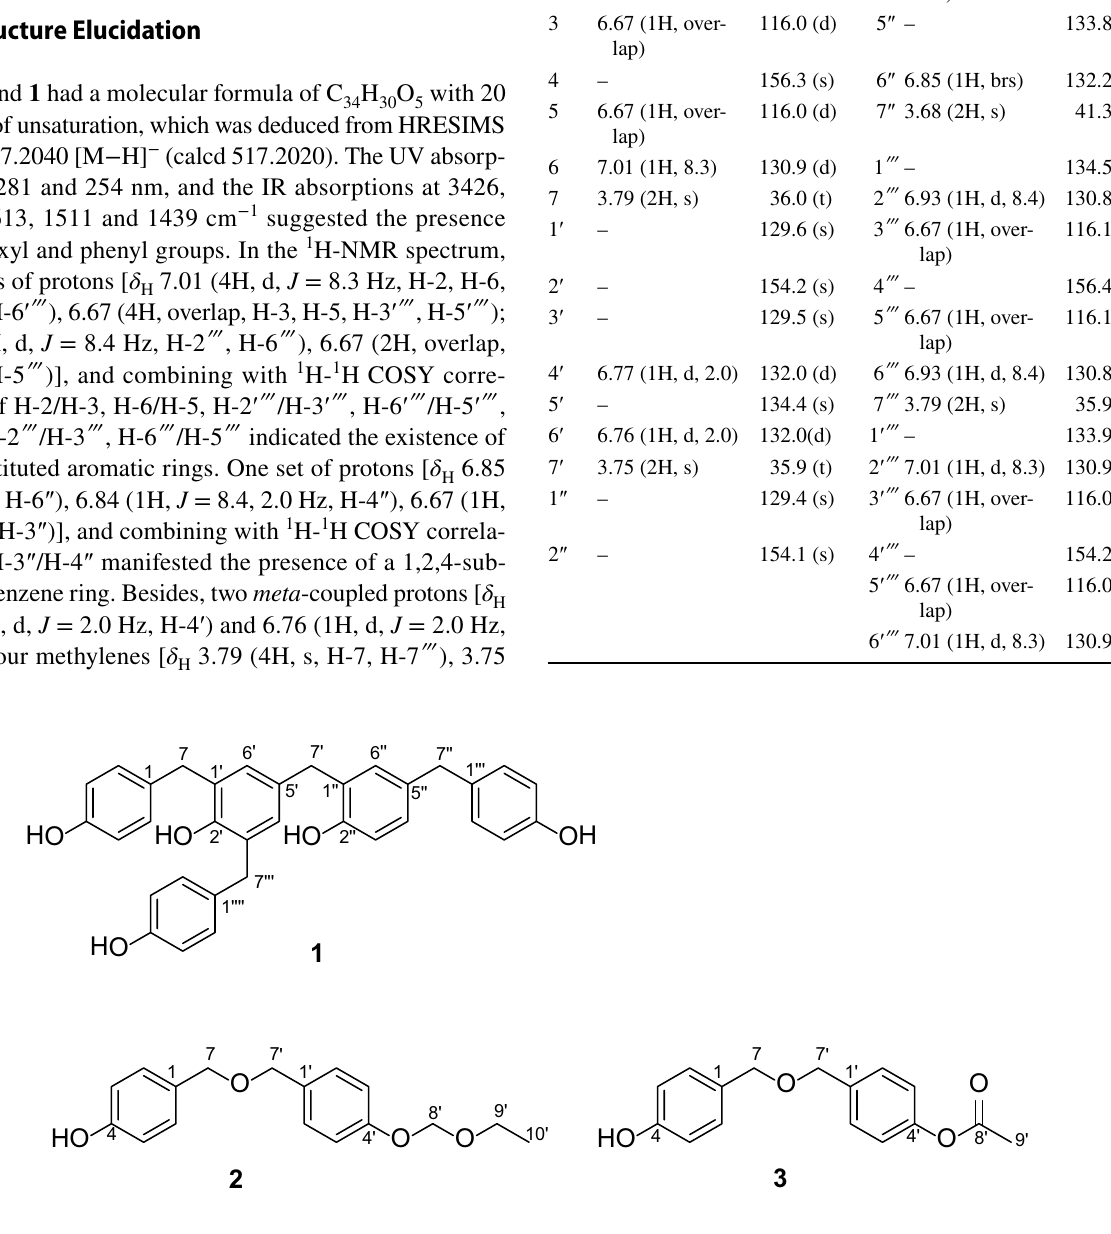
(Table 1). Compared with 4-[[2-hydroxy-5-(methoxymethyl)